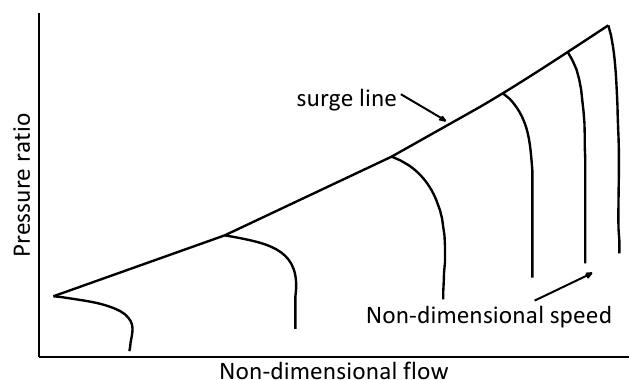
Figure 5. Schematic compressor map.